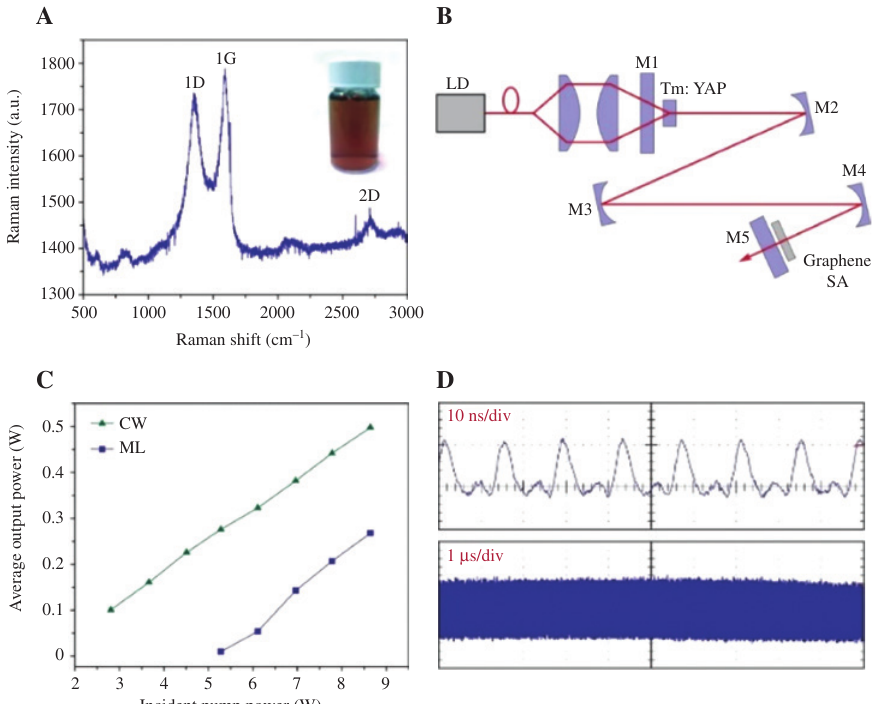
Figure 11: Performance of the first GO mode-locked Tm-doped laser. (A) Raman spectrum of graphene. Inset is the photo of graphene oxide aqueous dispersion. (B) Schematic of the graphene oxide absorber mode-locked Tm:YAG laser. (C) Output power vs. incident pump power. (D) Mode-locked pulse trains with graphene oxide as absorber. Reproduced with permission [189]. Copyright 2011, IOP